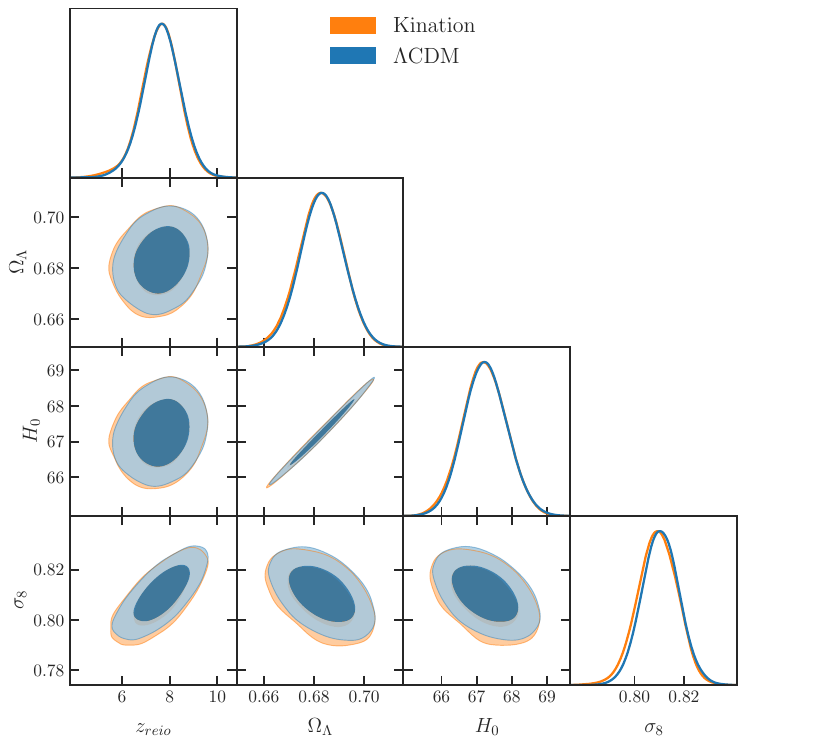
Figure 17 . Corner plot for the posterior distributions for the calculated values Λ CDM parameters and axion kination cosmology. Contours contain 68% and 95% of the